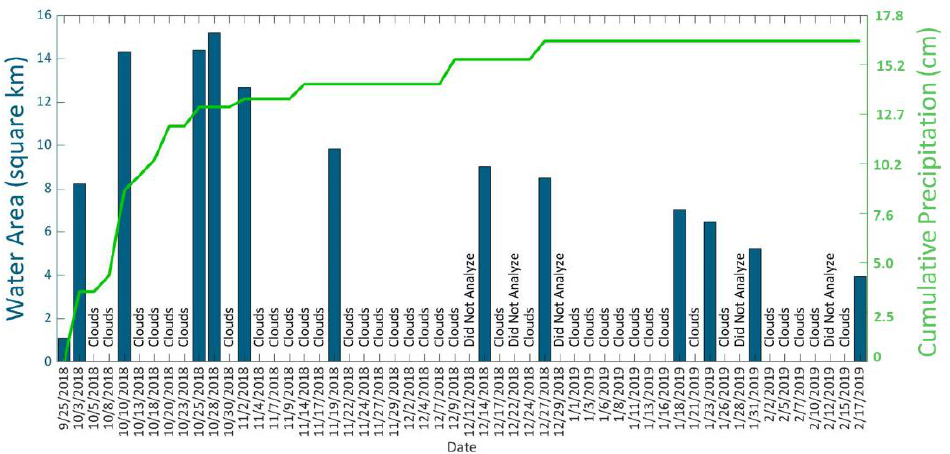
Figure 3. Observed surface water area (blue bar graph, in square kilometers) calculated for the 30 × 30 km square region shown in the brown square in Figure 1a for the period between 25 September 2018 and 17 February 2019. Missing dates are due to either cloud cover or data not being analyzed, as indicated on the plots. The corresponding cumulative precipitation at Plainview, Texas (in inches), is indicated by a green solid line (data courtesy of the National Weather Service through Mesowest https://mesowest.utah.edu (accessed on 15 March 2022).